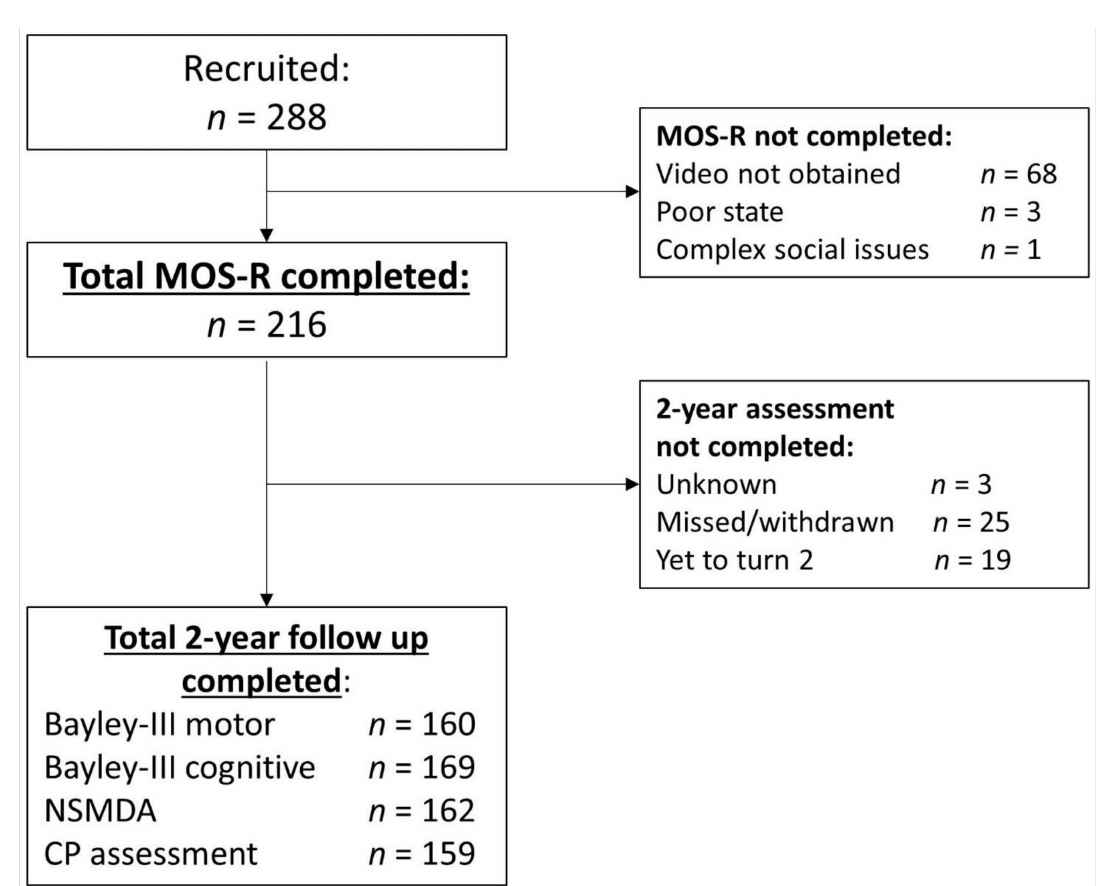
Figure 1. Flowchart of participants. Abbreviations: MOS-R: Motor Optimality Score, revised; Bayley- III: Bayley Scales of Infant and Toddler Development, 3rd edition; NSMDA: Neurological, Sensory, Motor Developmental Assessment; CP: cerebral